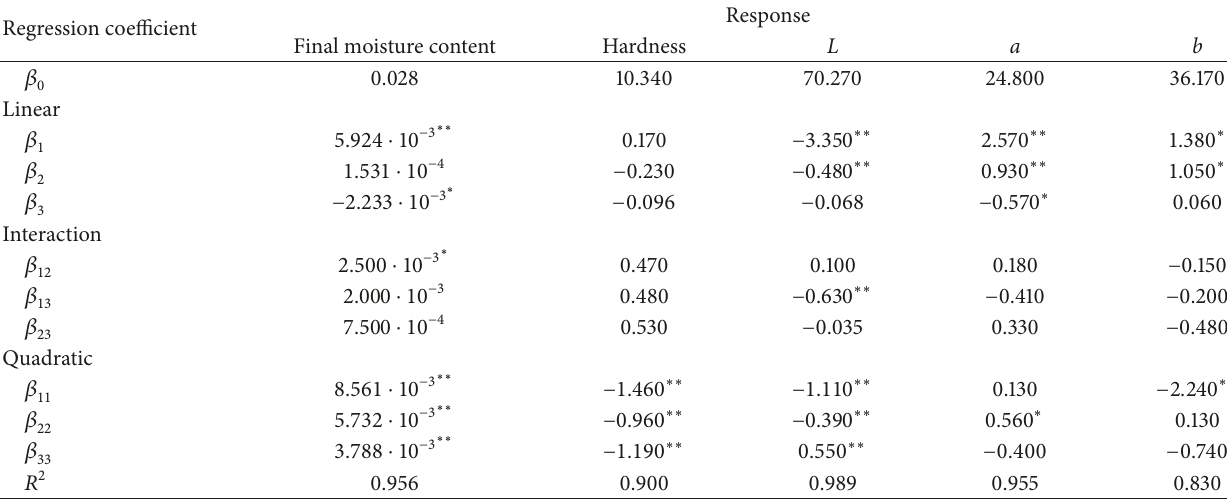
Table 3: Estimated coefficients of the fitted second-order polynomial models for the final moisture content, hardness, and color of the restructured